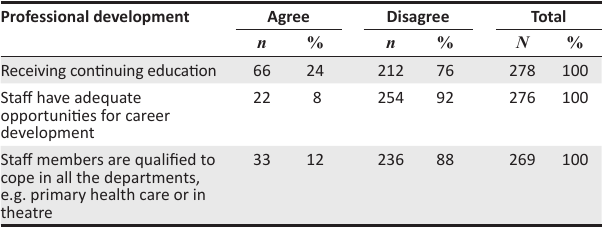
TABLE 3: Professional Development.